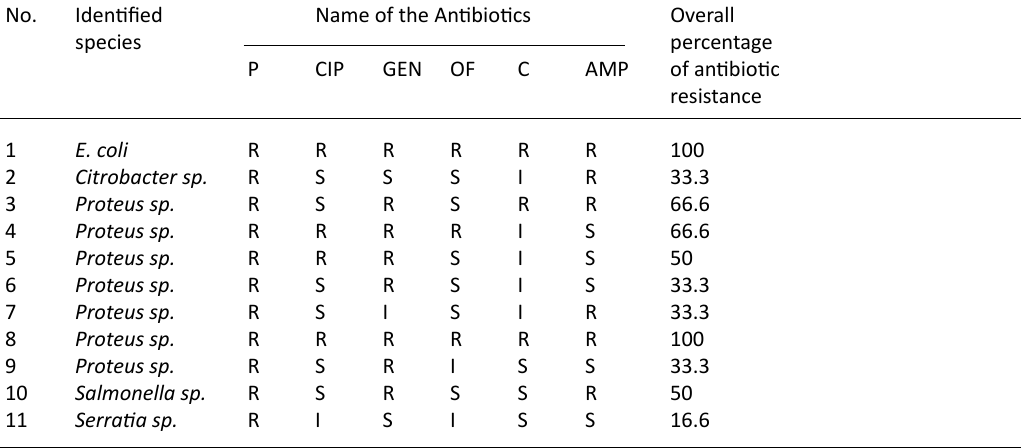
Table 2. Antimicrobial susceptibility of isolated bacteria against different antibiotics